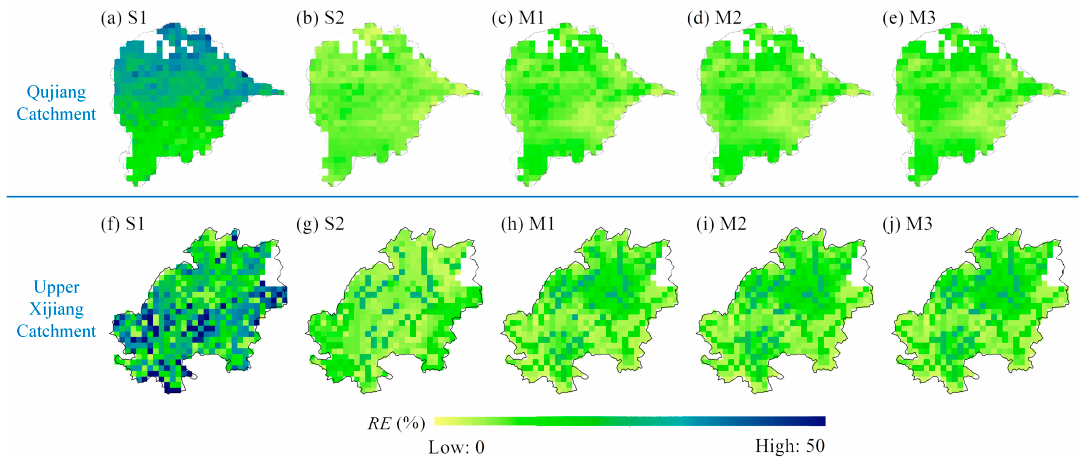
Figure 9. Gridded Residual Error ( RE ) for SM (%) based on the most likely parameter values in multiple scenarios (S1–S2, M1–M3) during the validation period in Qujiang catchment ( a – e ) and Upper Xijiang catchment ( f – j ).